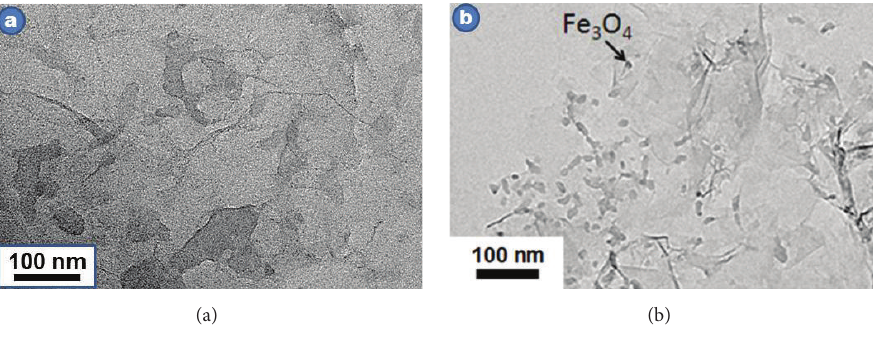
Figure 2: TEM image of GO (a) and Fe 3 O 4 /rGO (b).